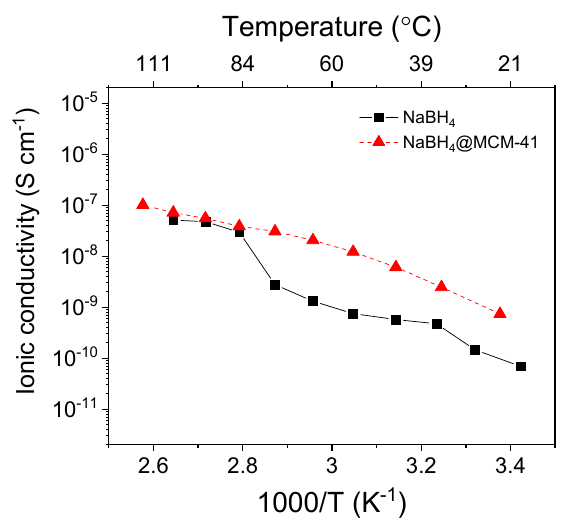
Figure 3. Arrhenius plot of NaBH 4 @MCM-41 and pristine NaBH 4 . The cause for the small “jump” in ionic conductivity for NaBH 4 is unknown as it does not correspond to any known phase